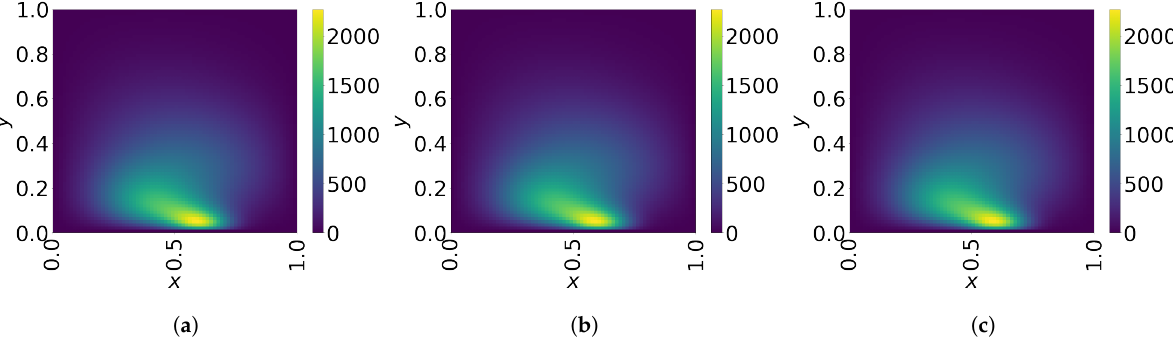
Figure 21. 2D linear convection diffusion equation with source term. Solution snapshots of FOM, Galerkin ROM, and LSPG ROM at t = 2. ( a ): FOM, ( b ): Galerkin ROM, ( c ): LSPG ROM.